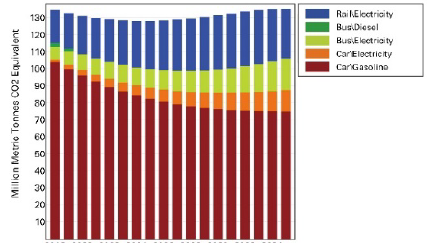
Figure 5. Scenario HHL’s 100-Year GWP: Direct (Demand) plus Indirect (Transformation) Emissions Allocated to Demands